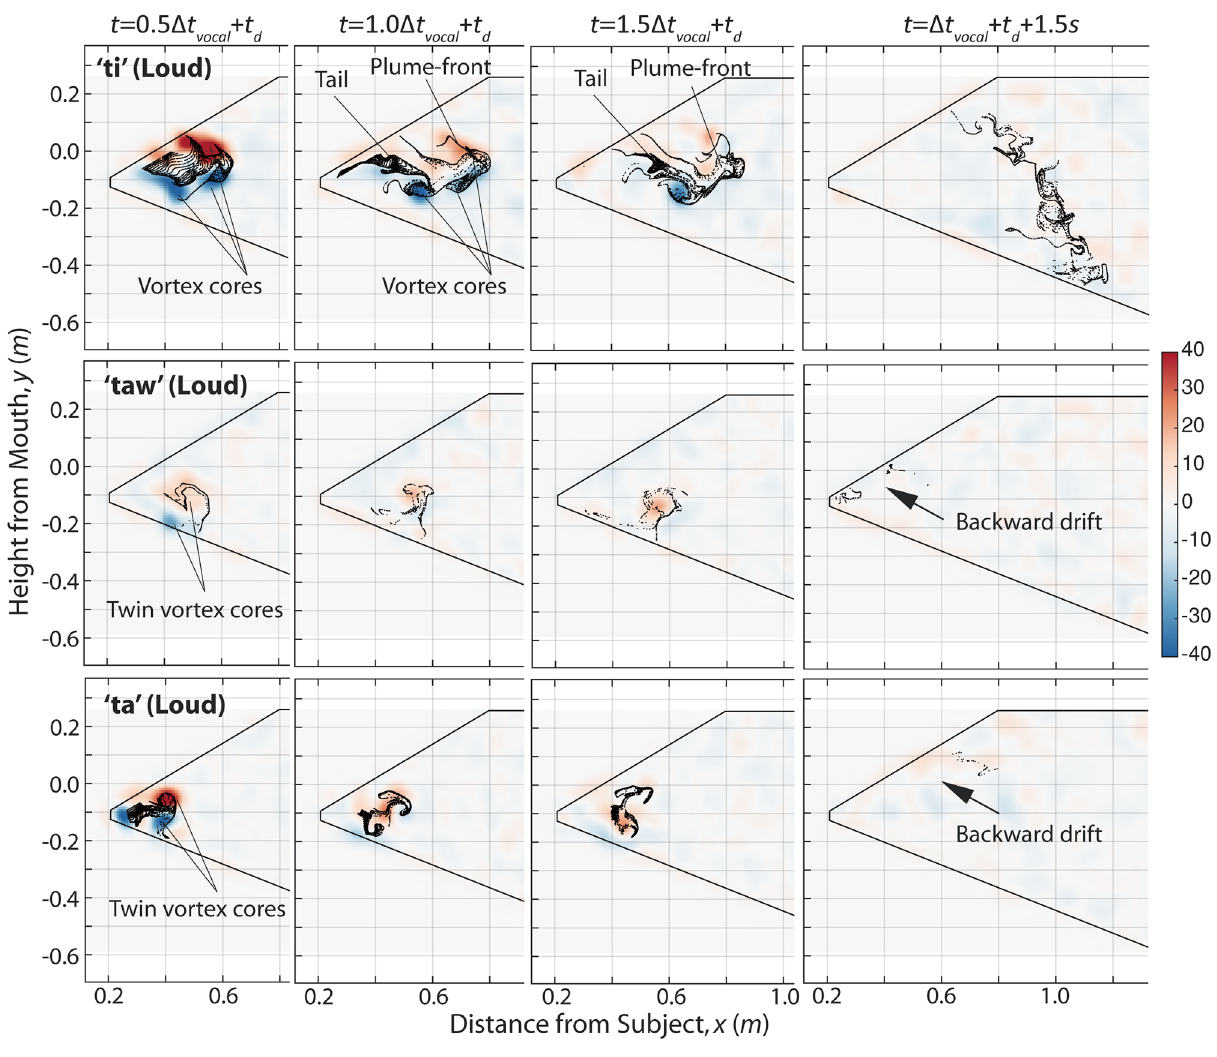
Figure 3. Dispersion dynamics of aerosol particles for plosives. Background: vorticity in s −1 torn and stretched downward. Due to the asymmetric tearing of the plume-front, aerosol particles were dispersed across a large range of distance in ‘ti.’ Aerosol plumes produced by the nasal sound ‘ma’ and fricatives ‘sa’ and ‘si’ are shown in Fig. 4. In contrast to cough and plosives, their L / D values based on maximum velocity were all on the order of 20, close to the critical L / D for classical starting jets. Due to their low penetration, the leading vortex cores were only briefly observed for ‘ma’ and ‘sa’ but not ‘si.’ In the former two cases, the plumes appear to retain a coherent vortex ring for longer durations (up to + 1.5 (cid:31) t vocal ) than cough and plosives, consistent with starting jets having lower L / D . Though no identifiable vortex cores remain at 1.5 s after vocalization, all three cases in Fig. 4 still exhibit a coherent swirling plume-front of aerosol particles at this stage, as opposed to cough and plosives where the plume-front became unrecognizably distorted.